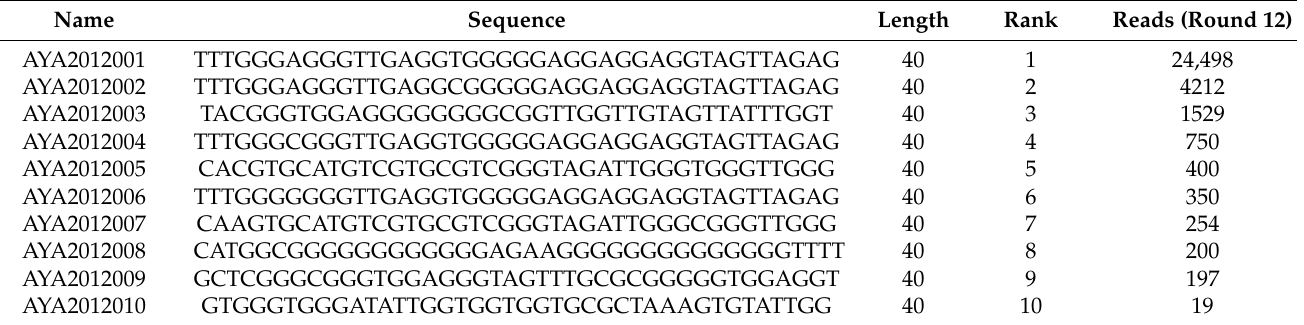
Table 1. Most abundant aptamer sequences after twelve rounds of